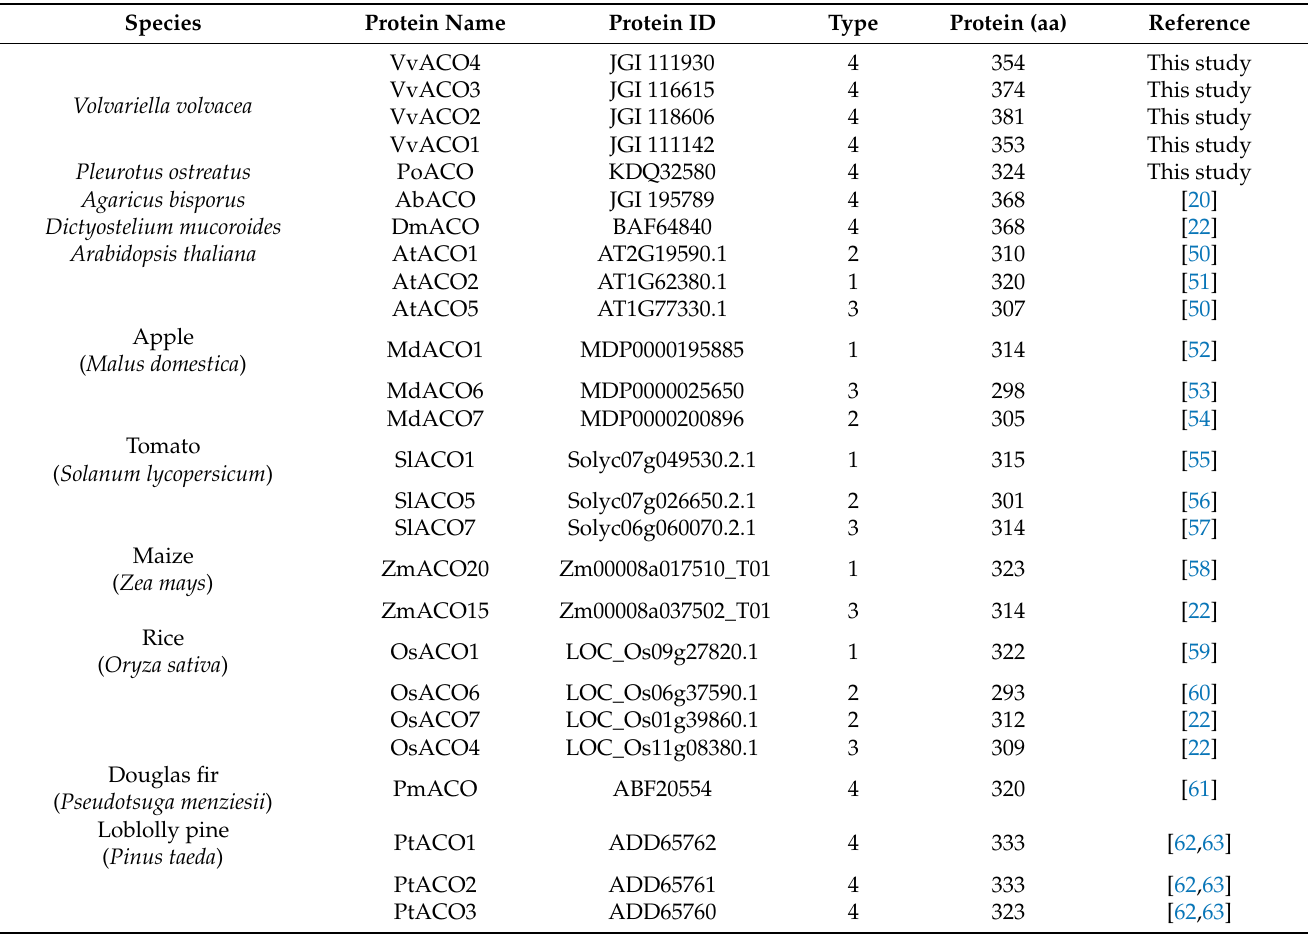
Table 2. Selected ACO sequences used in the phylogenetic